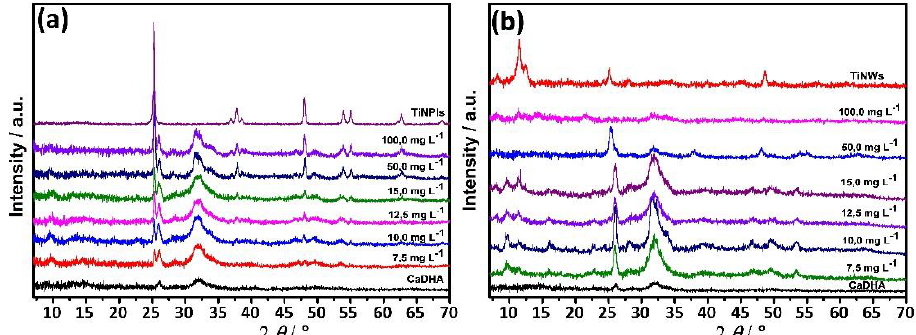
Figure 5. PXRD patterns of the precipitate formed in the control system (calcium-deficient hydroxyapatite, CaDHA) and in the presence of ( a ) TiO 2 nanoplates (TiNPls) and ( b ) TiO 2 nanowires (TiNWs) after 60 min reaction time. c (CaCl 2 ) = c (Na 2 HPO 4 ) = 4 · 10 −3 mol dm −3 , pH init = 7.4, ϑ = (25 ± 0.1) °C. Table 2. Crystallite size of calcium-deficient hydroxyapatite (CaDHA) formed in the control system and in the presence of TiO 2 nanoplates (TiNPls) and titanate nanowires (TiNWs) after 60 min reac-